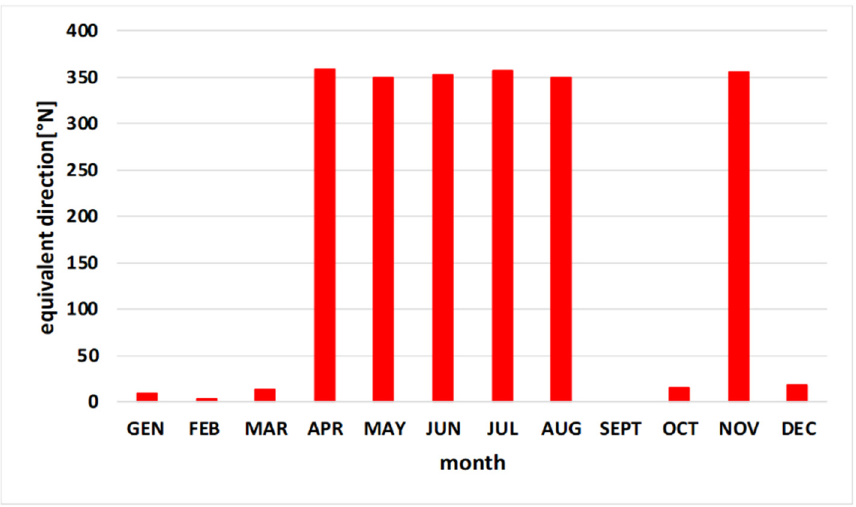
Figure 9. Monthly variation of the LDR equivalent direction of Molise climate